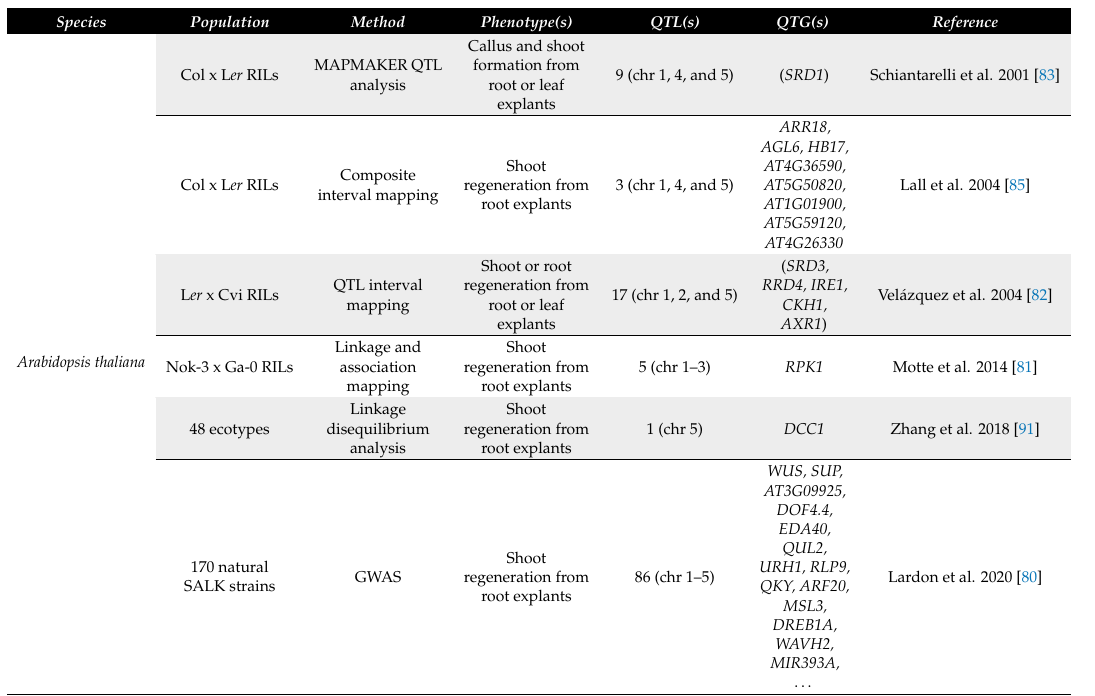
Table 1. Overview of QTL mapping studies on regeneration in Arabidopsis thaliana . The QTL and QTG columns respectively specify the number (and chromosomal position) of quantitative trait loci and highlight quantitative trait genes (plausible candidates are